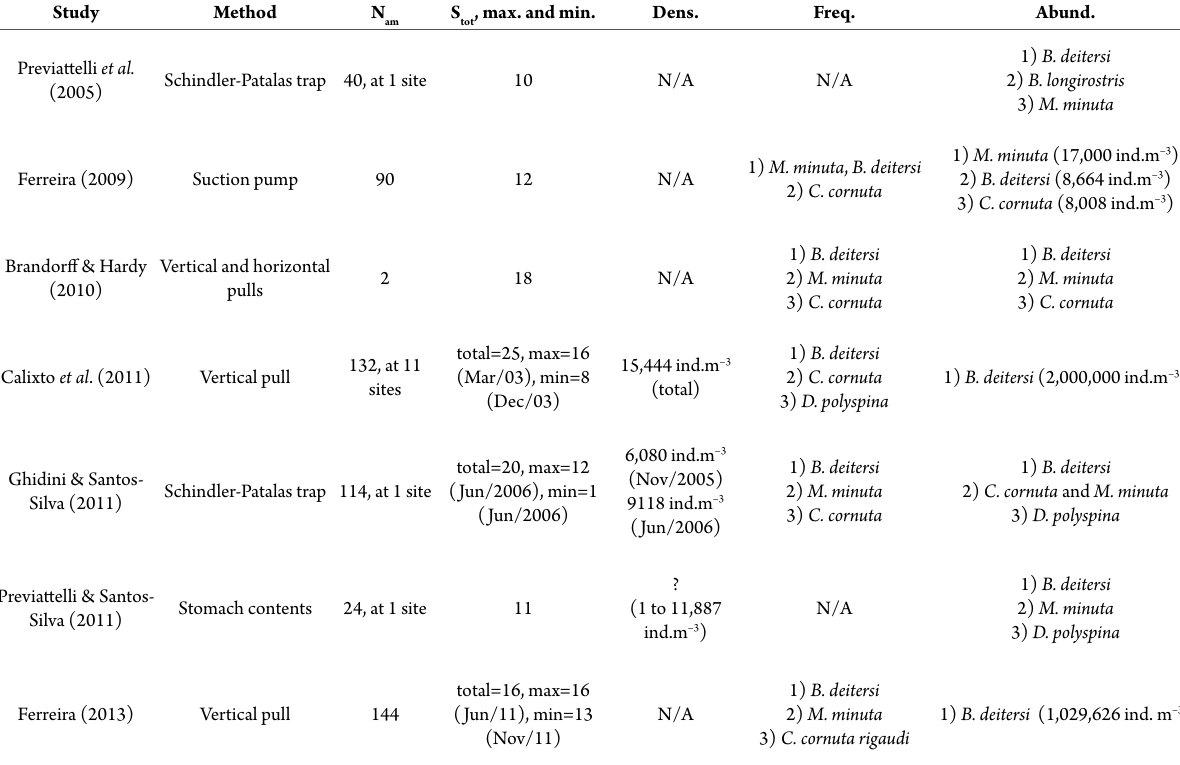
Table 2. Results obtained in previous studies with cladocerans (Crustacea: Anomopoda and Ctenopoda) in Tupé Lake. N number of samples taken; S = total species richness, maximum and minimum; Dens. = mean population density (ind.m –3 ); Freq. tot = most frequent species; Abund. = Most abundant